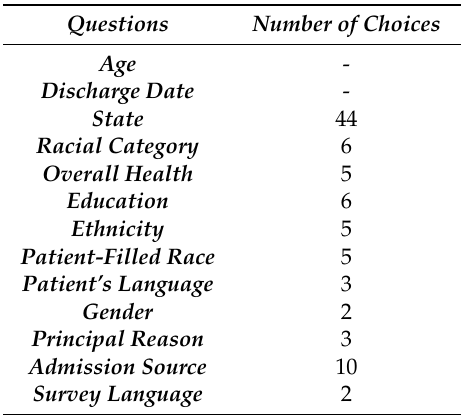
Table 2. Demographic Data